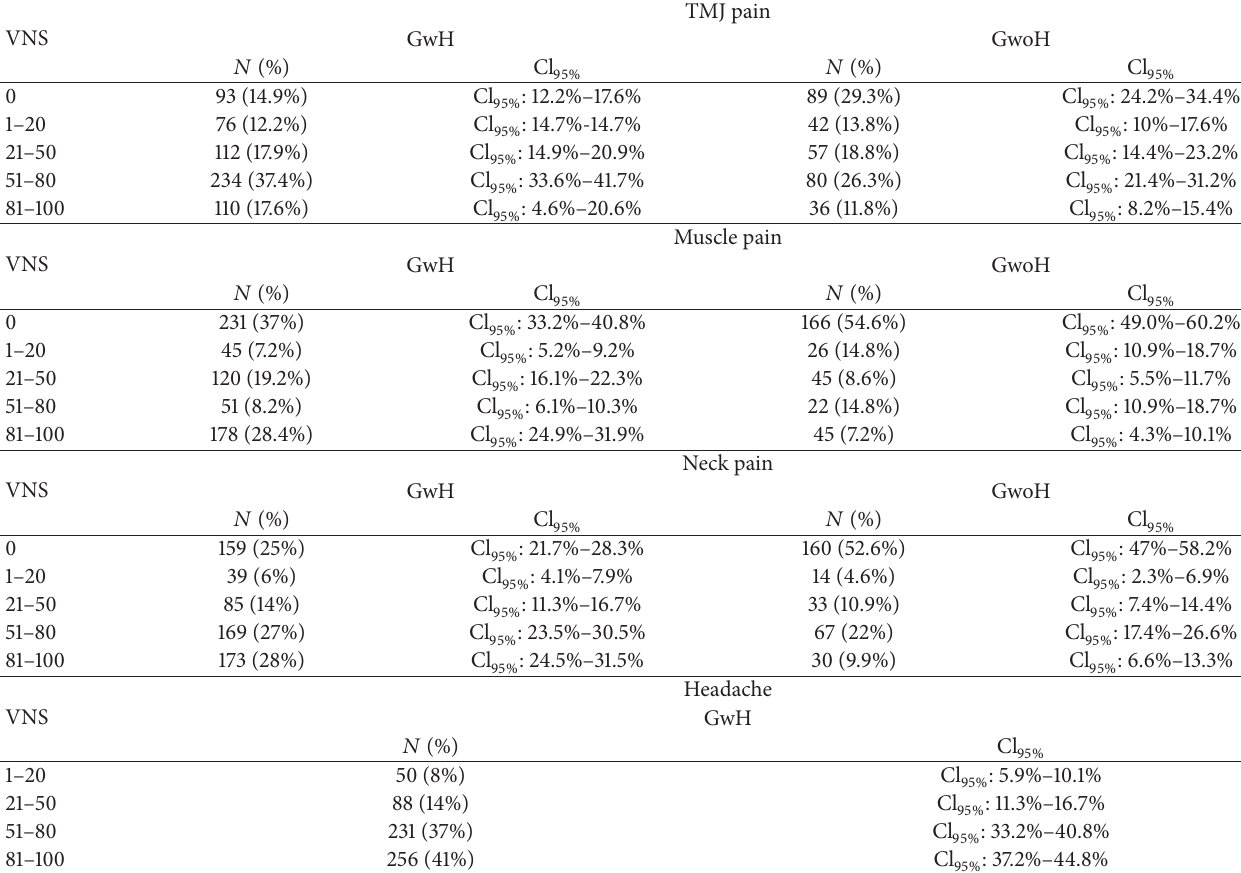
Table 3: Absolute frequency ( 𝑁 ) and percentage (%) values of prevalence of painful variables of cranium-facial districts (presence of joint pain, muscle pain, and neck pain) in Group with Headache (GwH) and Group without Headache (GwoH). TMJ: temporomandibular joint. VNS: Verbal Numeric Scale